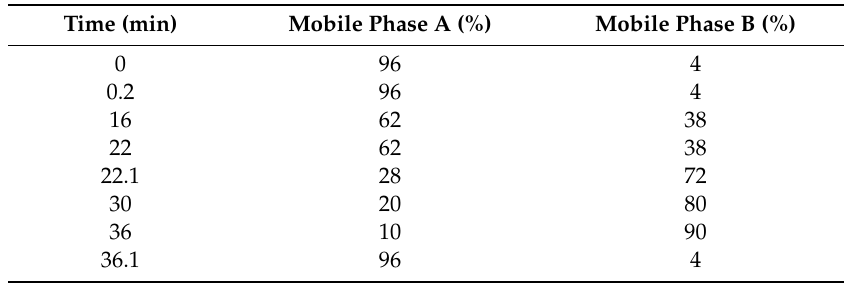
Table 3. Gradient set up for pigment analysis by HPLC-PDA. Mobile phase A is methanol: 225 mM ammonium acetate = 82:18 ( v / v ). Mobile phase B is ethanol.